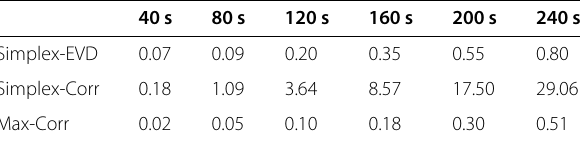
Table 4 Running times in seconds of methods for activity probability estimation